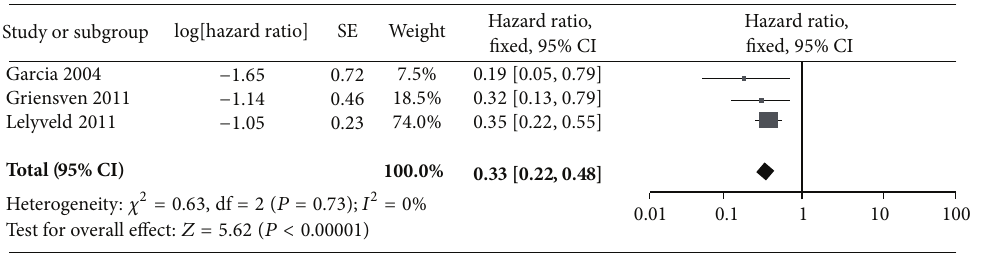
Figure 3: Forrest plot of 350–500 cells/ 𝜇 L group hazard